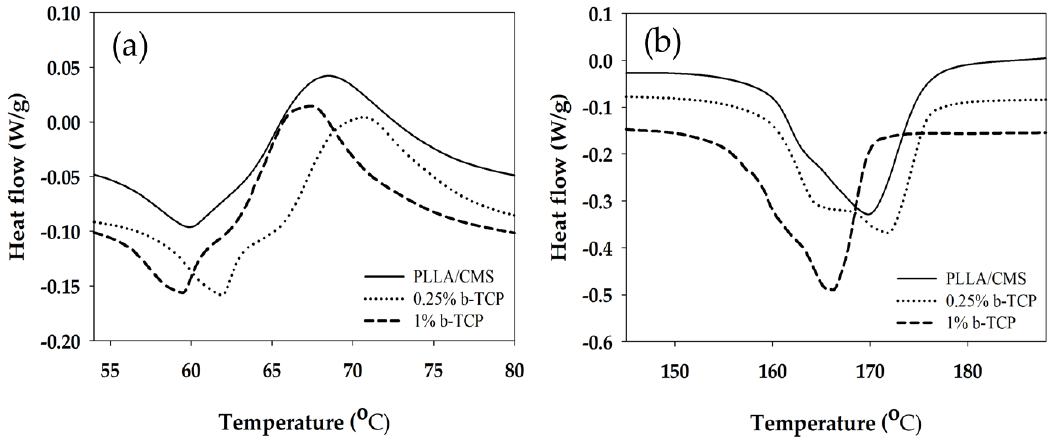
Figure 9. Differential scanning calorimeter ( DSC) curves show the ( a ) glass transition temperature ( T g ) and ( b ) T m for PLLA/CMS/β -TCP composite nanofibers at different concentration of β -TCP.